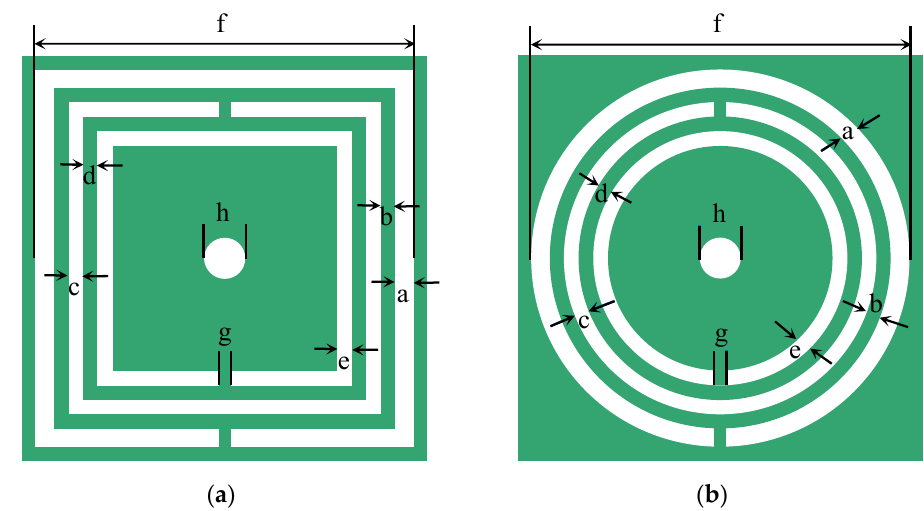
Figure 2. CSRR based on ( a ) rectangular structures; and ( b ) circular structures. Table 1. The Main Parameters for two types of CSRRs shown in Figure 1.